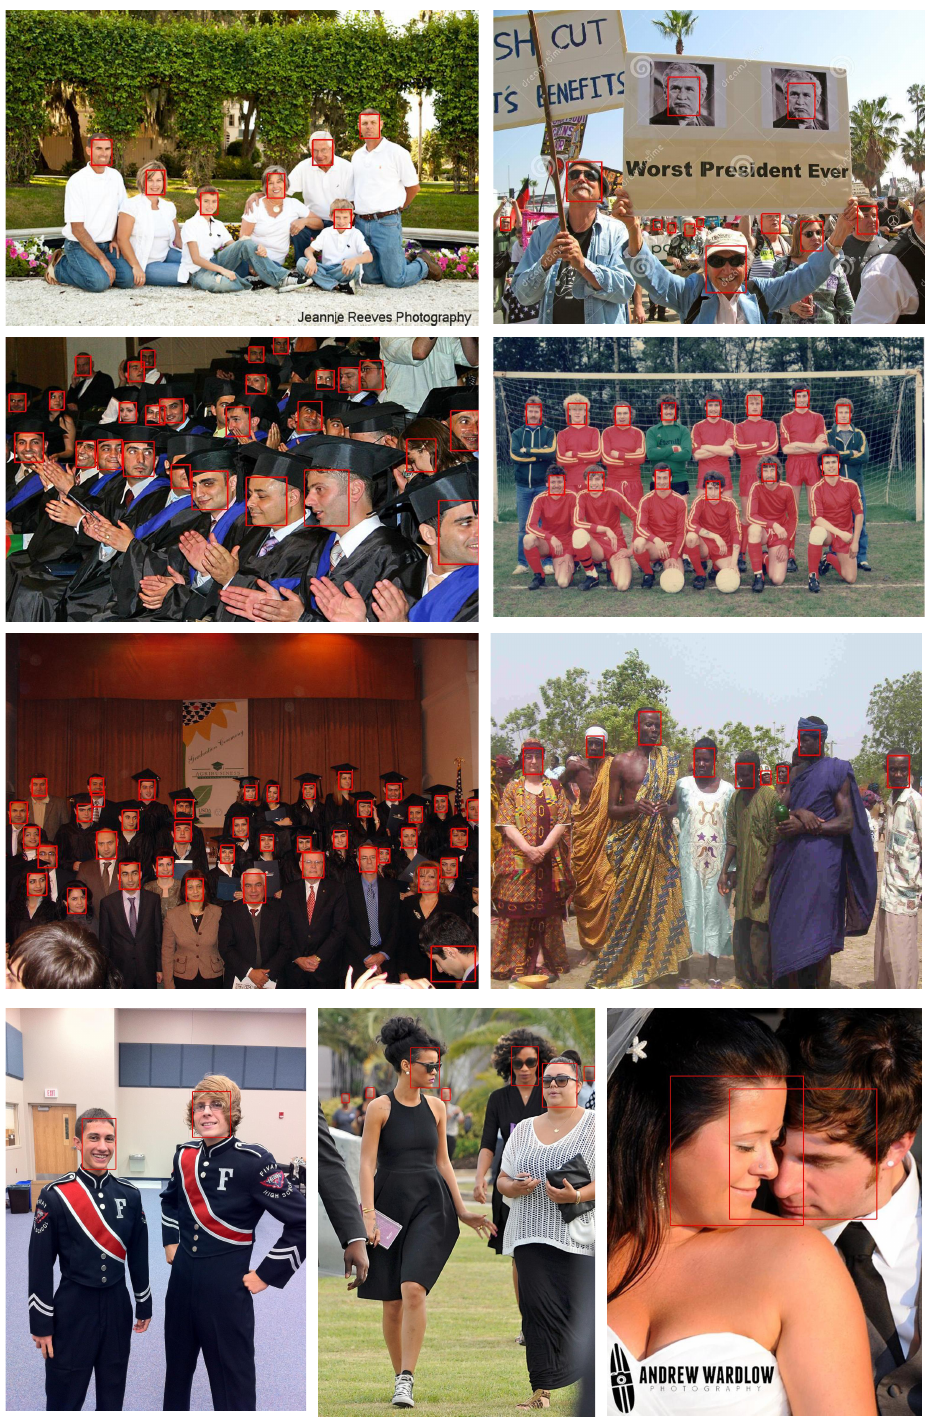
Figure 9. Visualization of the results of EagleEye on wider face